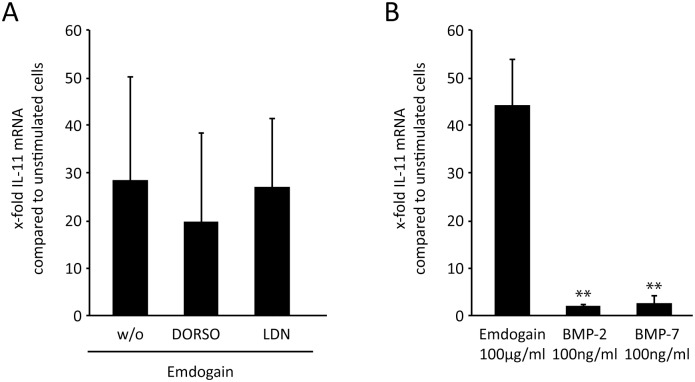
BMP receptors ALK2, ALK3, and ALK6 do not mediate the effect of Emdogain on IL-11 expression.Palatal fibroblasts were incubated with (A) 100 µg/ml Emdogain or serum-free medium alone and BMP type I receptor inhibitors dorsomorphin (DORSO; 10 µM) and LDN193189 (LDN; 10 µM). Palatal fibroblasts were also incubated with (B) recombinant human BMP-2 and BMP-7 (both 100 ng/ml). RT-PCR was performed for IL-11 **P<0.01 compared to Emdogain control. The data represent at least two experiments with cells from three donors (n = 6).